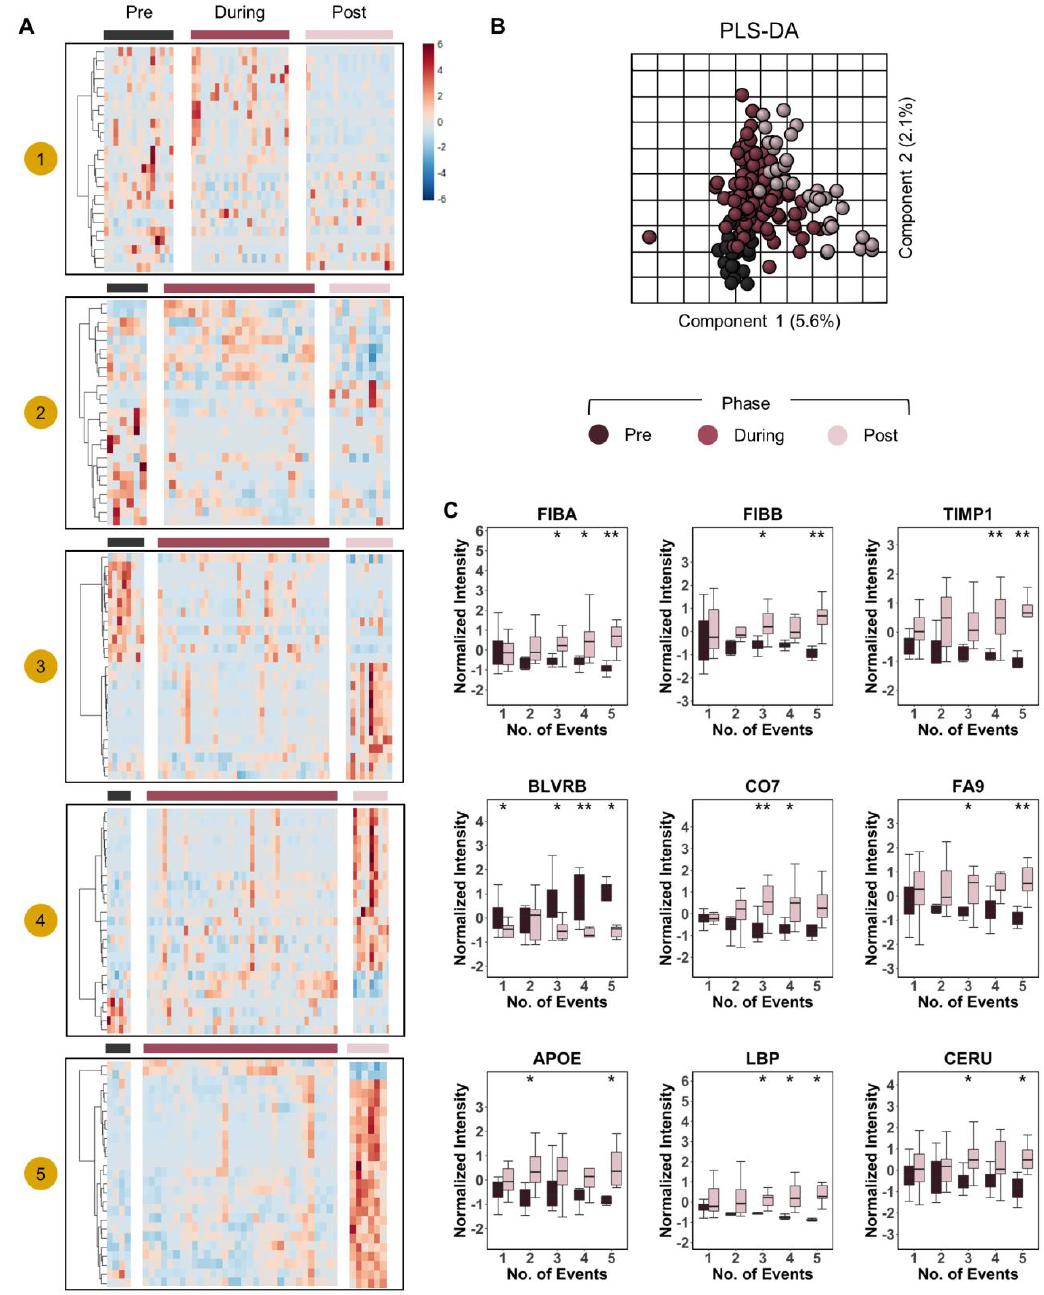
Figure 7. Dose-response effect of pRBC transfusion on the plasma proteome. In ( A ), heat maps of top 25 proteins that changed significantly in response to transfusion as measured by ANOVA ( y -axis) with patients on the x -axis. The heat maps were divided into transfusion phases “pre-during-post” and grouped by the number of transfusion “events” 1–5. In ( B ), PLS-DA of patient proteomes grouped by transfusion phase. Patients that received strictly greater than one transfusion event were included in PLS-DA. In ( C ), we show box plots of select proteins that changed significantly in response to transfusion. Box plot colors correspond to pre and post transfusion time points, consistent with panels ( A , B ). ** p < 0.01, * p < 0.05 .